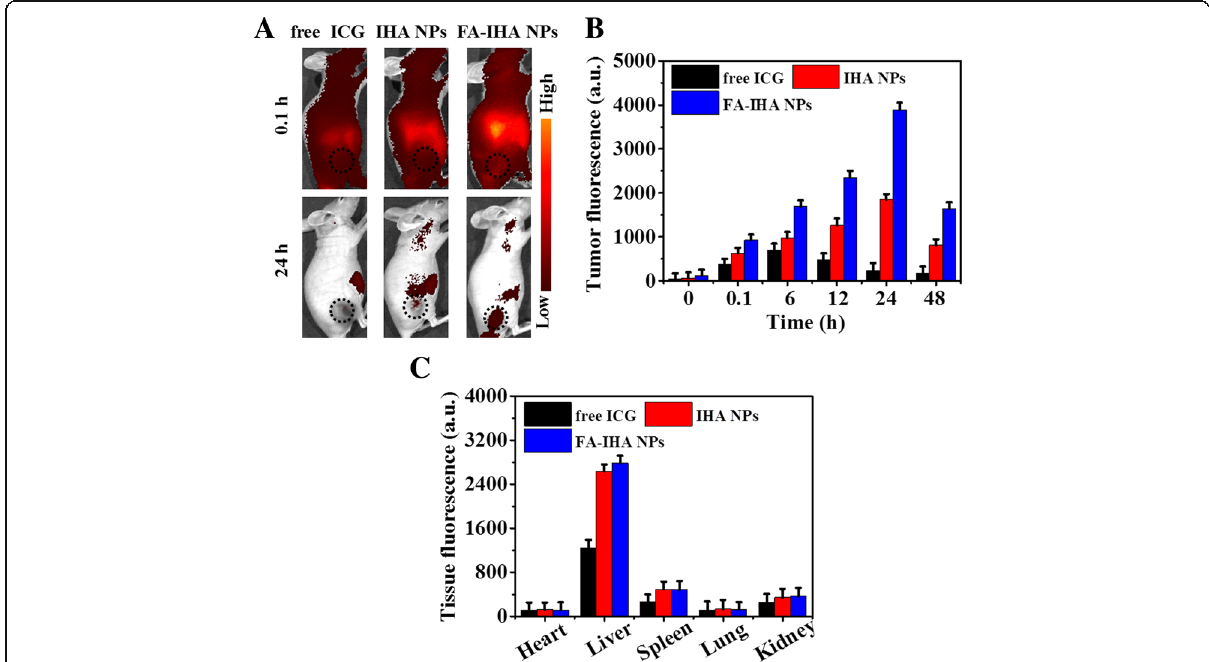
Fig. 8 a Representative fluorescence images of tumor-bearing mice after tail vein injection with free ICG, IHA NPs, and FA-RIPNPs. The black dashed circles indicate the tumor region. b Quantitative in vivo analysis of the fluorescence signal in the tumor regions of mice treated with free ICG, IHA NPs, and FA-IHA NPs as a function of injection time. c The fluorescence signal of major organs including heart, liver, spleen, lungs, and kidney